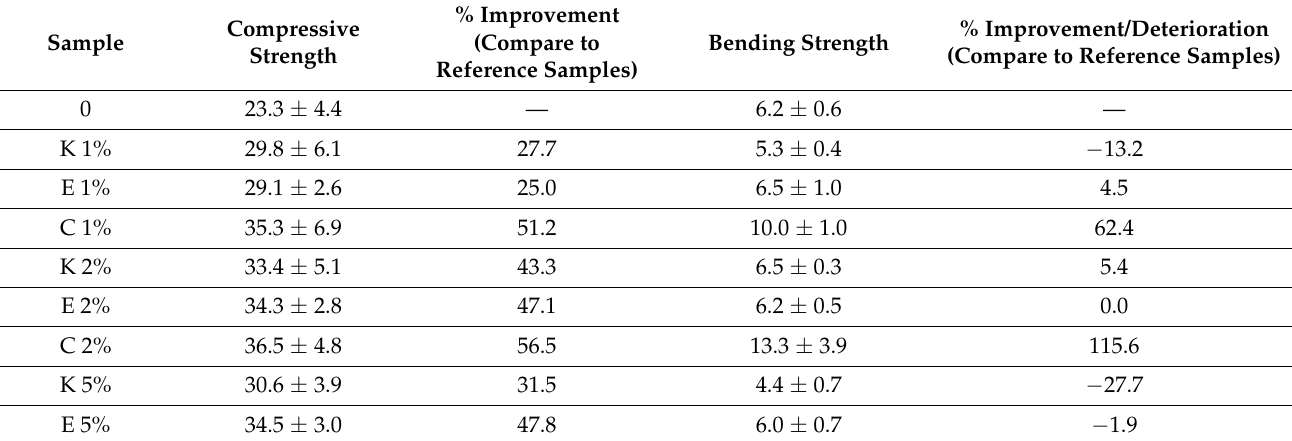
Table 8. Summary of composite test results—compressive and bending strength after 28